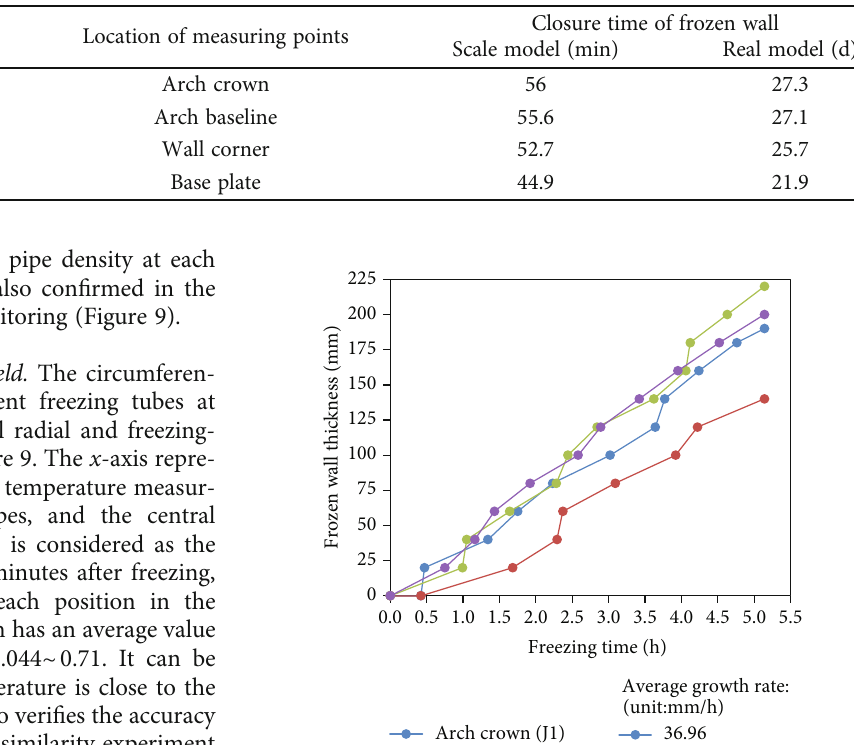
Table 2: Closure time of frozen wall.